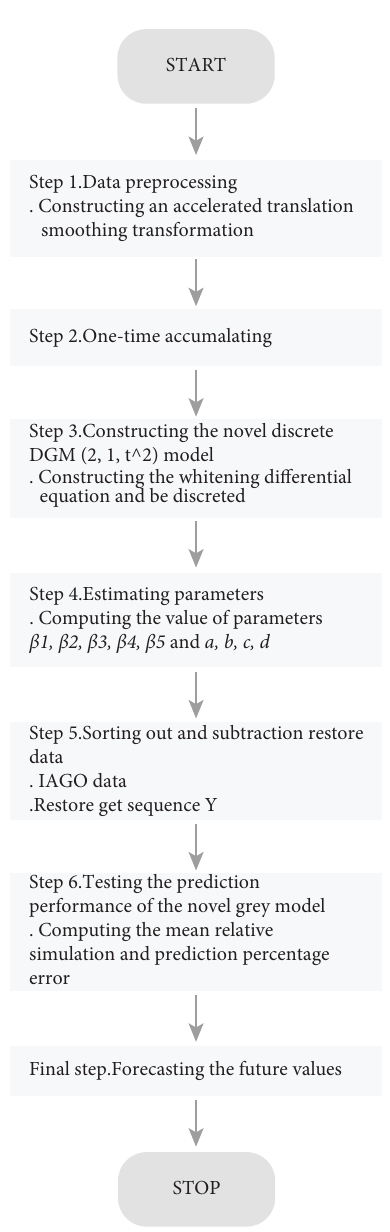
Figure 1: Flow chart of the algorithmic steps.